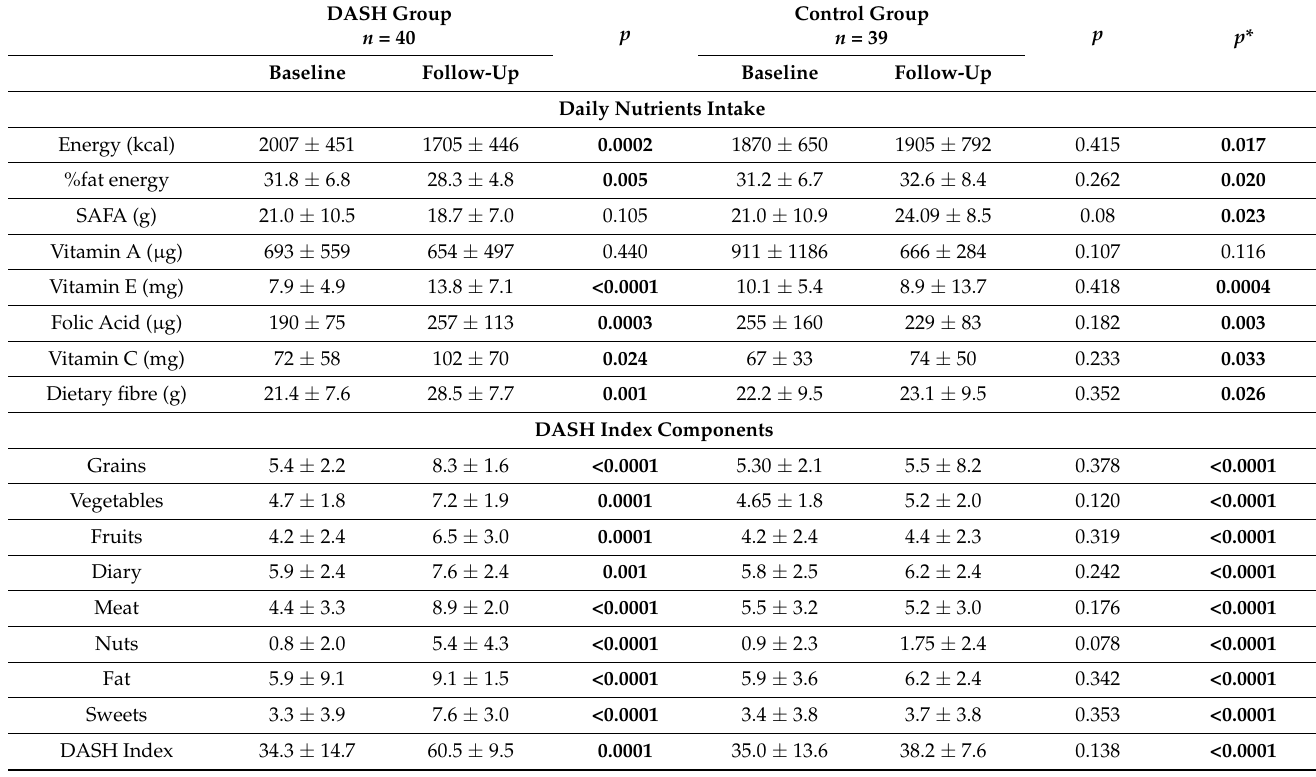
Table 3. Daily intake of selected nutrients and DASH index values in both study groups. p indicates differences within the group (paired samples t -test). p * indicates differences between groups (independent samples t -test). Statistically significant p -values are marked in bold.